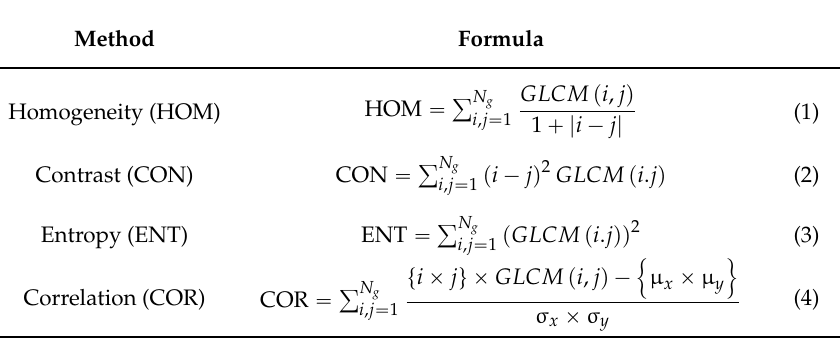
Table 2. The Grey-Level Co-Occurrence Matrix (GLCM) features used in this